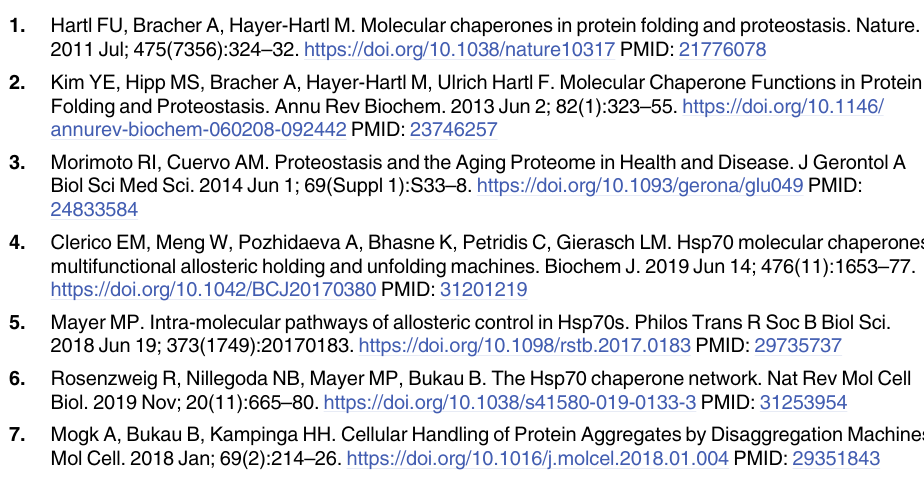
S16 Fig. Convergence of Interaction Energies. To demonstrate that the length of simulations is appropriate, here is an example of traces for a simulation run for L at site 0 that was 50 ns long, roughly 10 times the length we thought would be necessary. The interactions plotted are (A) Total Interaction Potential energy (kcal/mol), (B) Van der Waals, (C) Electrostatic, (D) Harmonic restraint, and (E) Solvent Accessible Surface Area ( Å 2 ). The slight transition just before 30 ns corresponded to a conformational change from the rotamer basin corresponding to the initial configuration into a secondary conformational basin. In fact, all of the short simu- lations of leucine (5 total, started from 5 rotamers) ended up in similar regions to these to rota- mer basins. (TIF) S17 Fig. Convergence of Total Energies. The lowest potential energy traces at site 0 for (A) L and (B) R, respectively. The average total energy was calculated for the last 3/5 of the 3 ns dynamics for each of rotamer-initiated simulation. The lowest-energy trajectory was used to calculate the interaction energies for each site.